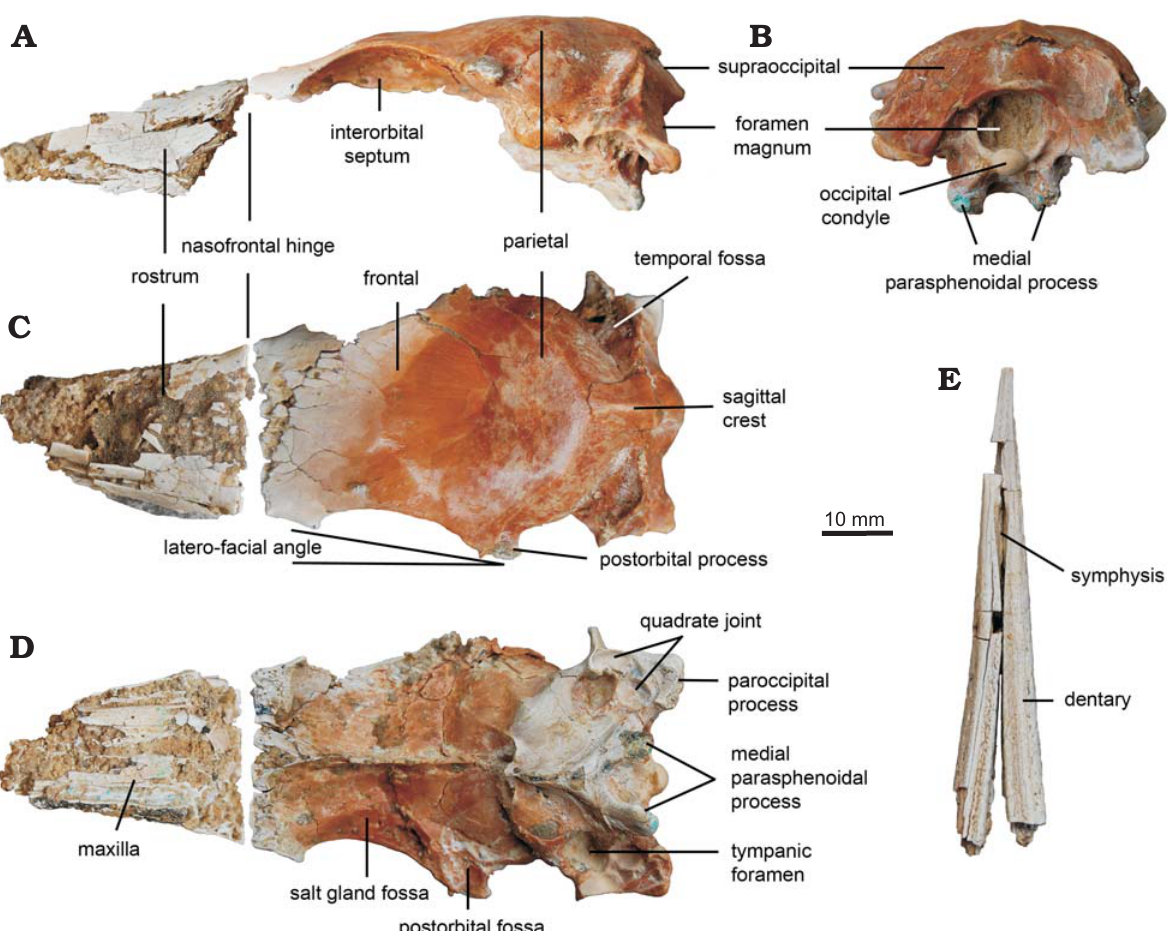
Fig. 2. Sulid bird Sula brandi sp. nov., holotype MUSM 2497 from Cerro Colorado locality, Peru, Pisco Formation, early Late Miocene. Skull in lateral ( A ), posterior ( B ), dorsal ( C ), and ventral ( D ) views; mandible in dorsal view ( E